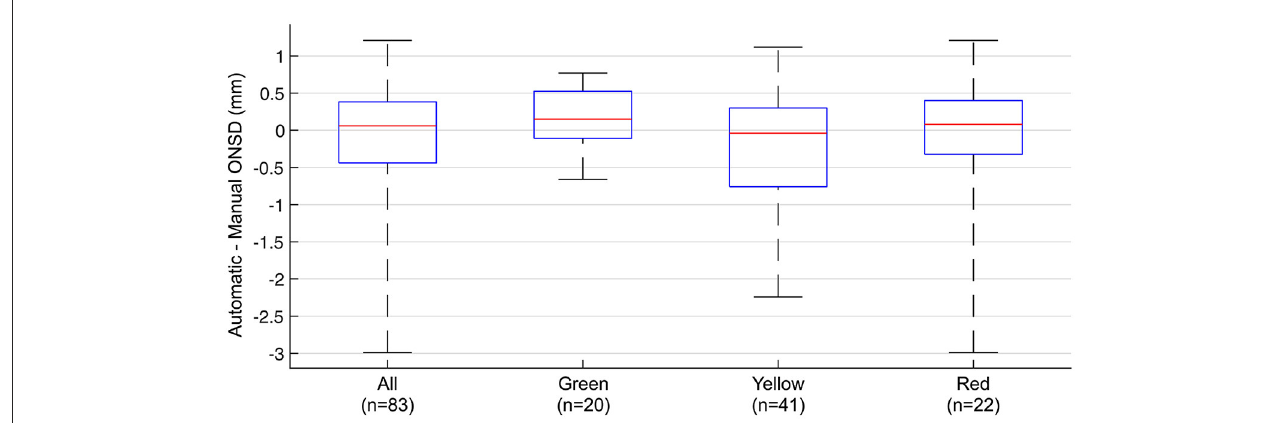
FIGURE5 Agreement between automatically and manually measured optic nerve sheath diameter by subgroups of the automatic software’s judgement of optic nerve axis alignment in the image sequences . Pairwise difference between automatically and manually measured ONSD in all measurements and subgroups. Box plots showing median, IQR, and range. Green, yellow, and red represents the automatic software’s judgement of the optic nerve axis in the image